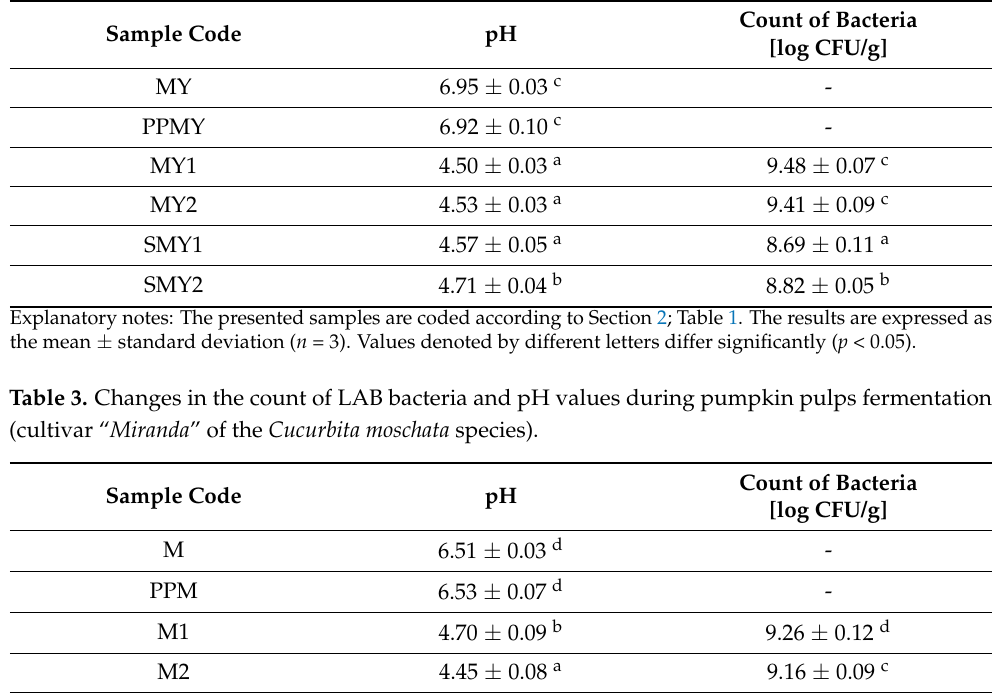
Table 2. Changes in the count of LAB bacteria and pH values during pumpkin pulps fermentation (cultivar “ Melon Yellow ” of the Cucurbita maxima species).